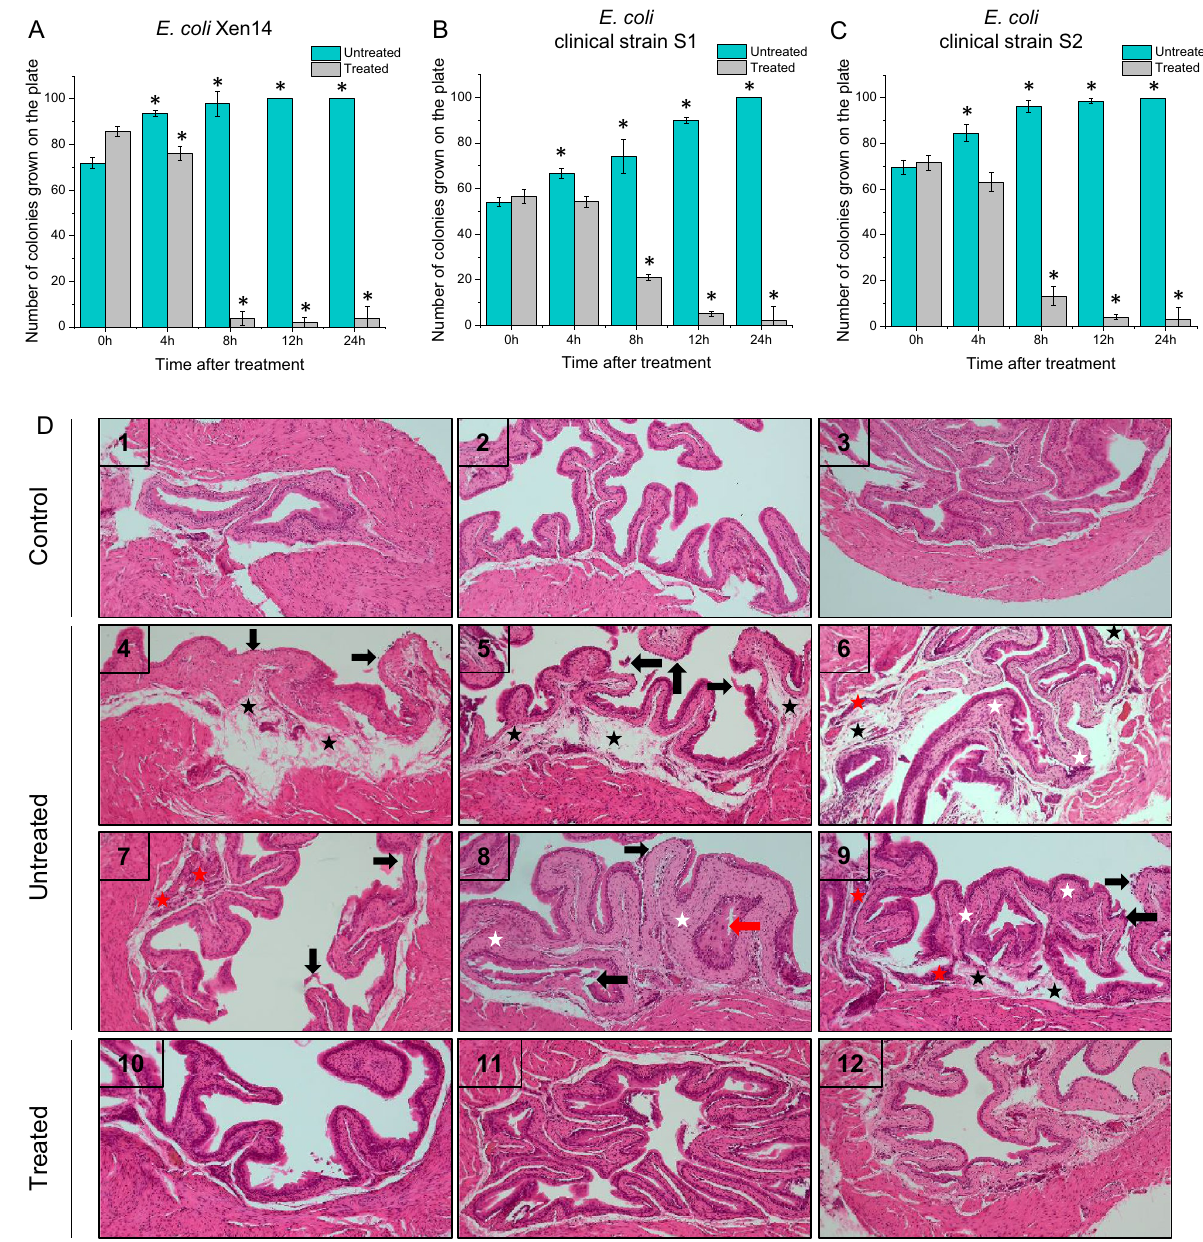
Figure 4. Decrease in E. coli Xen14 colonies in urine culture from mice post CSA-13 IRDye800CW treatment (grey columns) when compared to urinary tract infected untreated mice (green columns) ( A ) and decrease in E. coli clinical strains (S1, ( B ) and S2 ( C ), colonies in urine culture from mice post CSA-13 treatment (grey columns) when compared to urinary tract infected untreated mice (green columns). Histological analysis of mice bladder tissues: (1–3) normal murine bladder; (4–9) murine bladder infected with E. coli Xen14; tissue edema (black star), exfoliation of transitional epithelial cells (black arrow), invasion of inflammatory cells in the mucosa (red star), and bladder mucosa hyperplasia (red arrows) (10–12) Murine bladder infected with E. coli Xen14 and treated with CSA-13 ( D